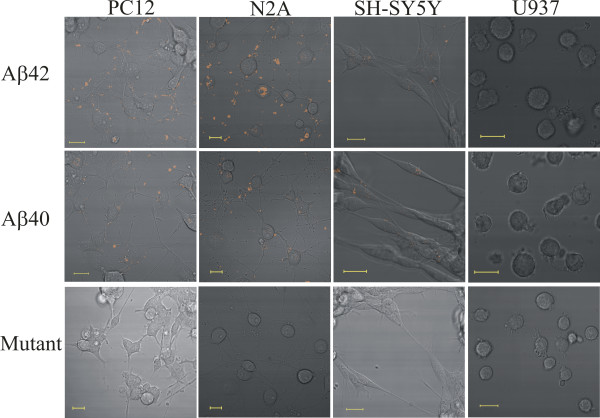
Confocal microscopy images of various cell lines treated for 12 hours with TMR-labelled peptides. All scale bars are 20 μm in length. The fluorescent emissions of TMR-labelled peptides are indicated in red. Aβ42 displayed the greatest cell surface binding among the peptides to the differentiated neuronal cell lines (PC12, N2A and SH-SY5Y). The mutant peptide was not observed to associate with any of the cell lines tested. None of the peptides tested associated with the U937 cells.